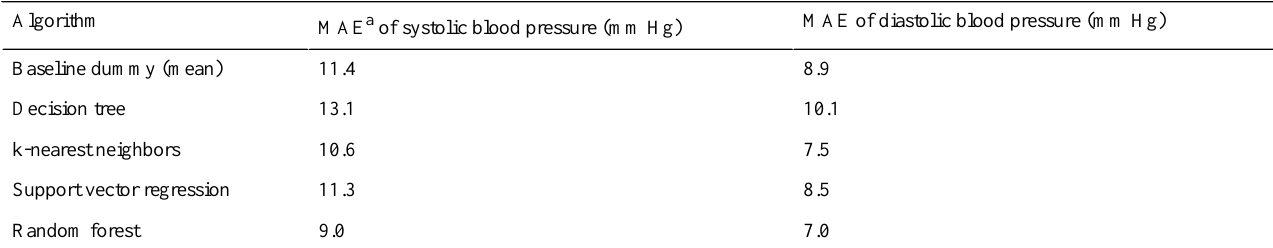
Table 2. MAEs of systolic blood pressure and diastolic blood pressure estimation of personalized models from the HeartMan trial.